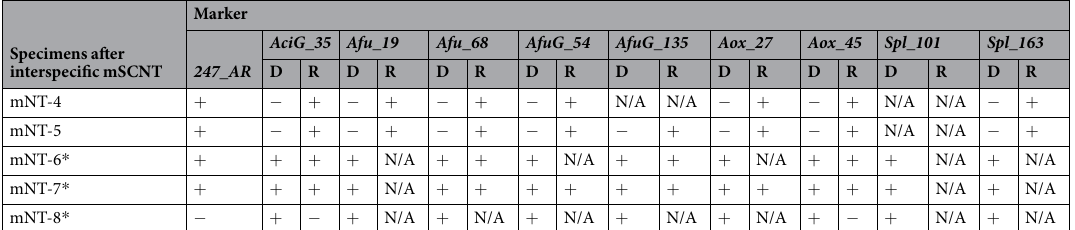
Table 3. Molecular analysis using microsatellites markers after interspecific mSCNT. The Russian sturgeon mNTs-6 and 7 contain alleles from both Russian sturgeon donor and sterlet recipient. The Russian sturgeon mNT-8 dispays only Russian sturgeon donor genome. Name of specimens is from mNT-4 to 8 as they are different from specimen mNT-1 to 3 in Fig. 2. D = donor; R = recipient; + = informative allele(s) present in allele phenotype of the sample; − = informative allele(s) not present in allele phenotype of the sample; N/A = not informative locus. * Specimens possessing all informative alleles from the